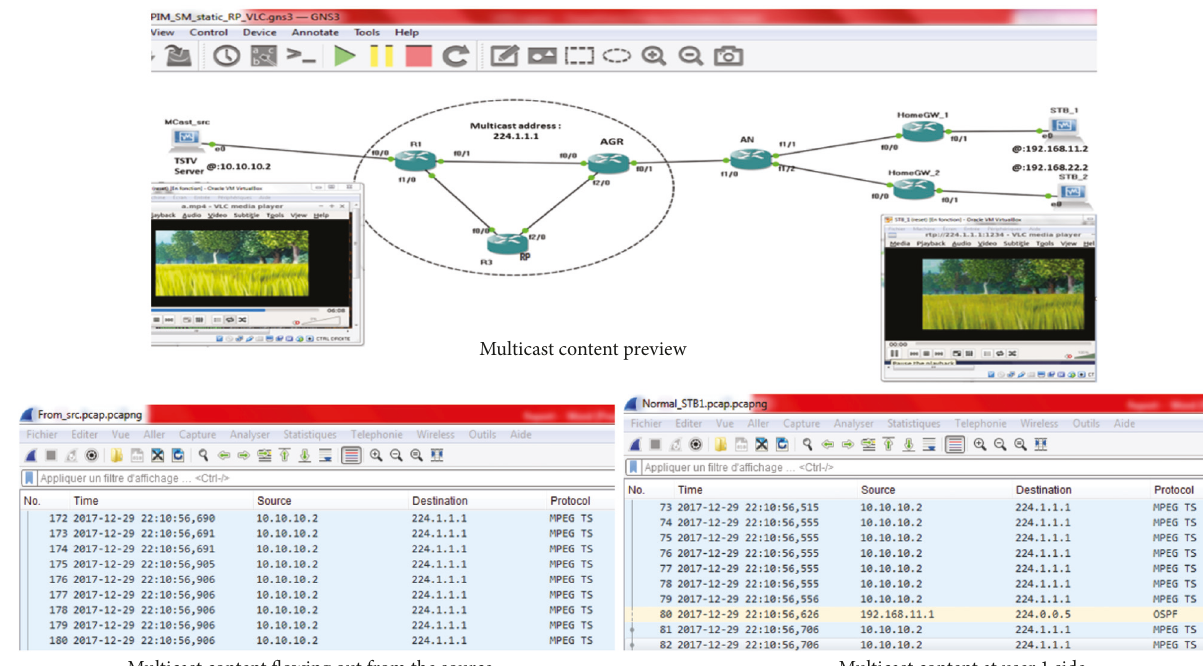
Figure 12: Multicast content flowing out from the source to user 1 trace and